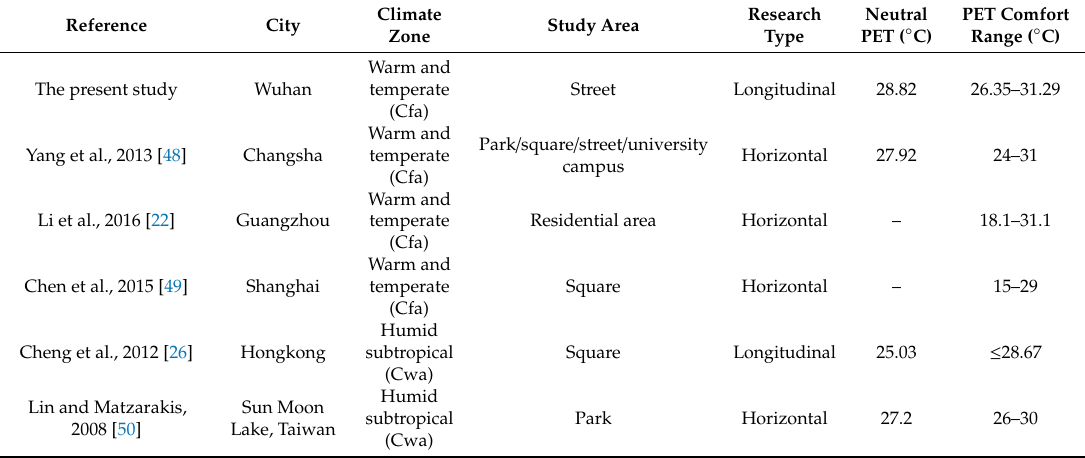
Figure 10. ( a ) Correlation between the mean thermal sensation votes (MTSV) and physiologically equivalent temperature (PET); ( b ) correlation between the thermal acceptable rate and PET. Table 4. Comparison of neutral physiologically equivalent temperature (PET) and PET comfort ranges in several large cities in